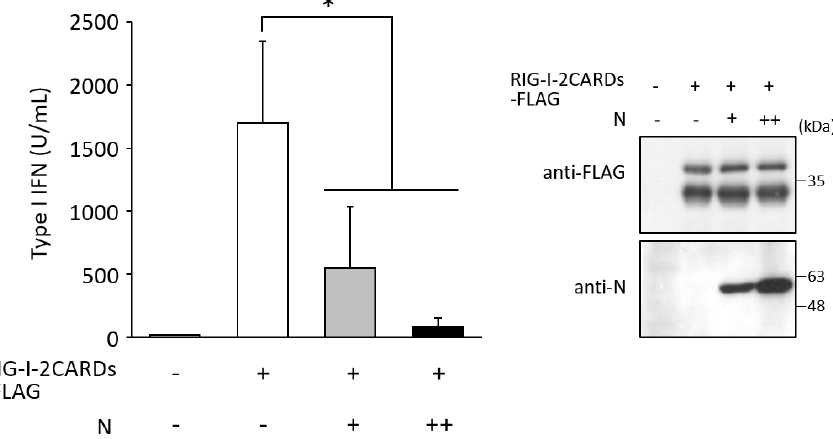
Figure 6. Effects of N protein on type I IFN production. COS cells were transfected with the indicated plasmids. ++ indicates twice the amount of pcDNA3.1-N as +. The supernatants were incubated with HEK-Blue IFN- α / β cells. The supernatants from HEK-Blue IFN- α / β cells were reacted with QUANTI-Blue solution, and SEAP activity was measured. SEAP activity was compared with a standard curve made by serial dilutions (10 – 10,000 U/mL) of IFN- α. Data are the means from four independent experiments. p values were calculated by the Student’s t test. *, p < 0.05. Error bars indicate standard deviations. Immunoblot shows the expression of RIG-I-2CARDs and N protein in transfected COS cells.